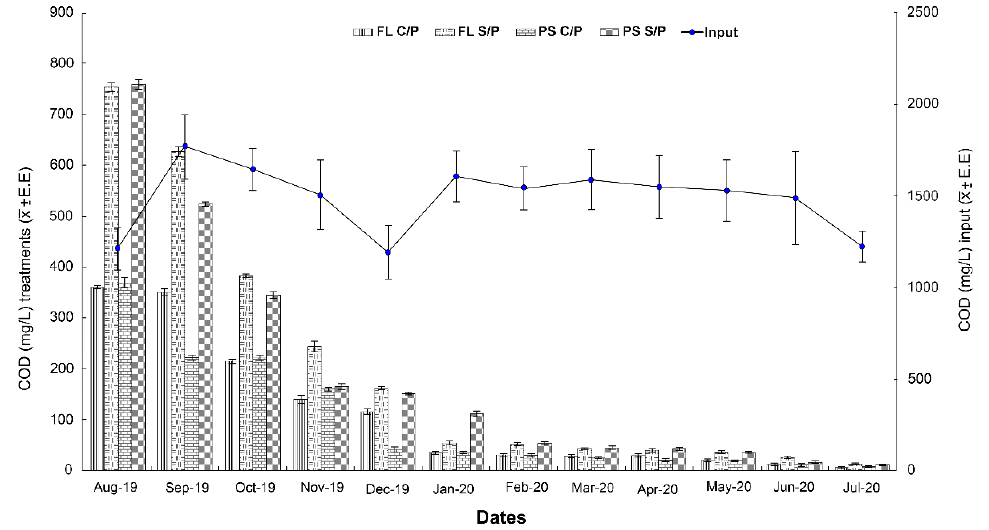
Figure 7. Average COD concentrations ( ± E.E.) during the experiment. (FLCP: free flow with plant; FLSP: free flow without plant; PSCP: saturated flow with plant; PSSP: saturated flow with plant; E.E.: standard